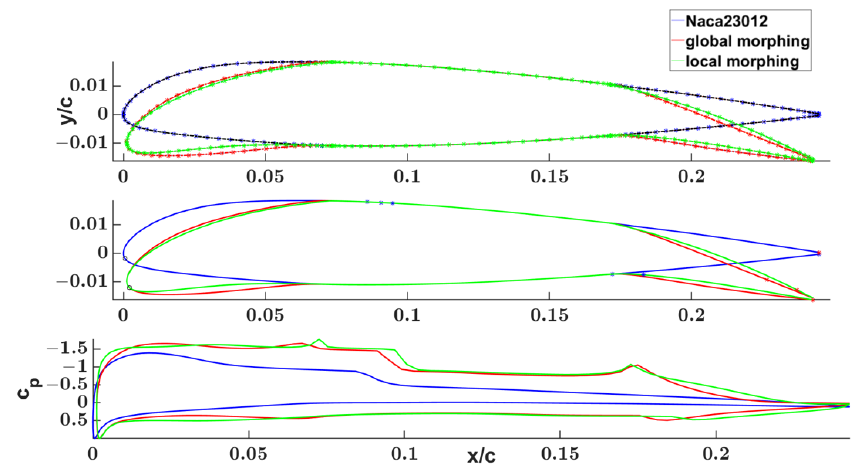
Figure 39. NACA 23012 undeformed, global, and local morphing geometries and pressure coeffi- cients.